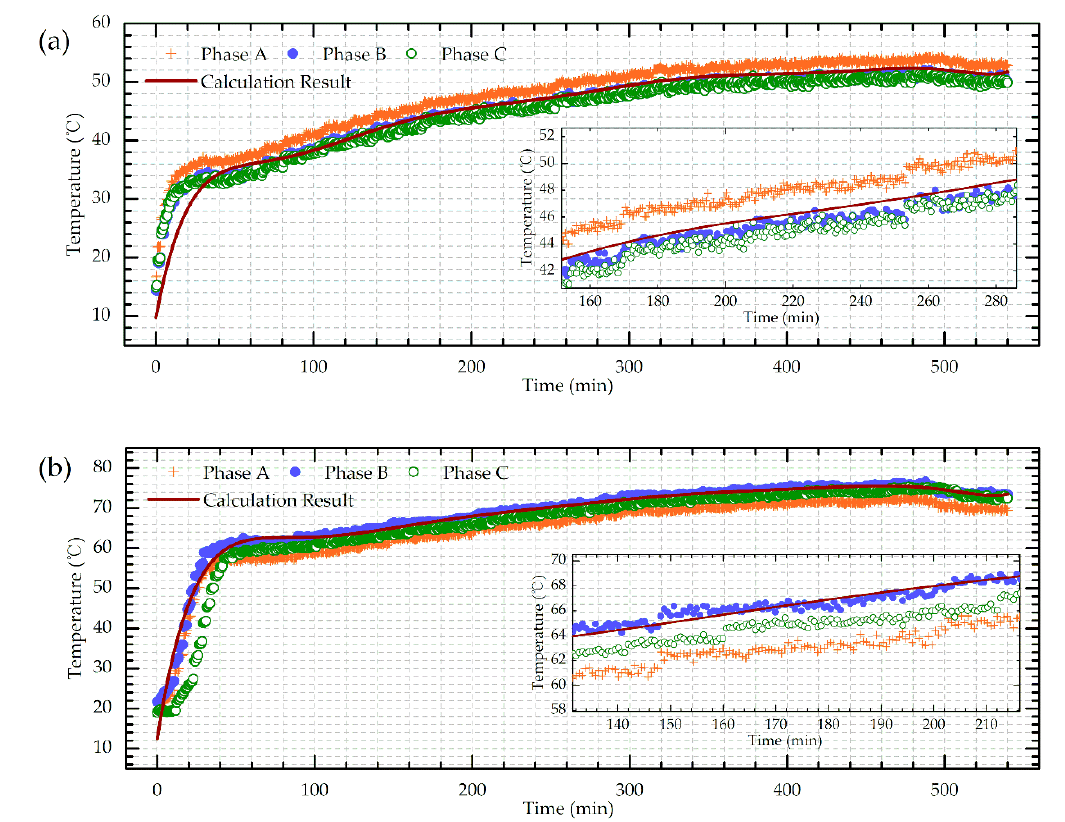
Figure 11. Hotspot temperature transient process of ( a ) HV winding; ( b ) LV winding.